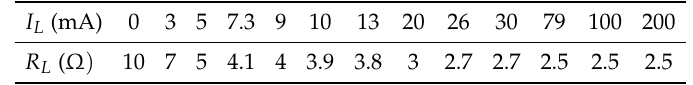
Table 4. Dependence of the WSN node load resistance on the load current